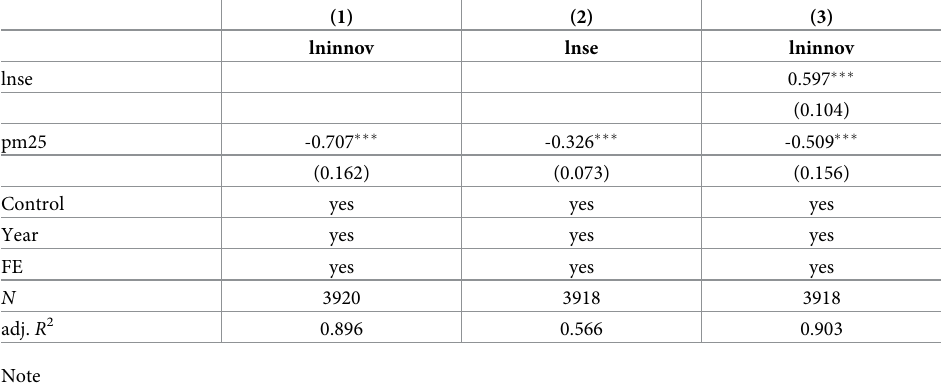
Table 6. Mediation of